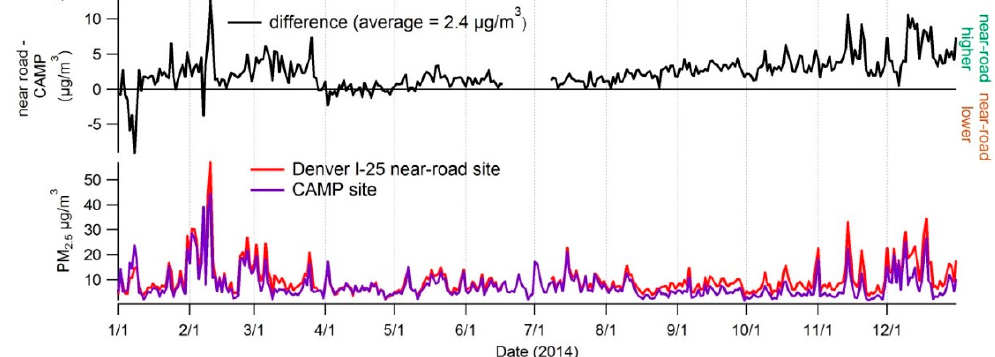
Figure 5. Daily PM 2.5 concentration at the official Denver near-road site, the maximum concentration of all other nearby sites, and the difference between the two concentrations during 2014.